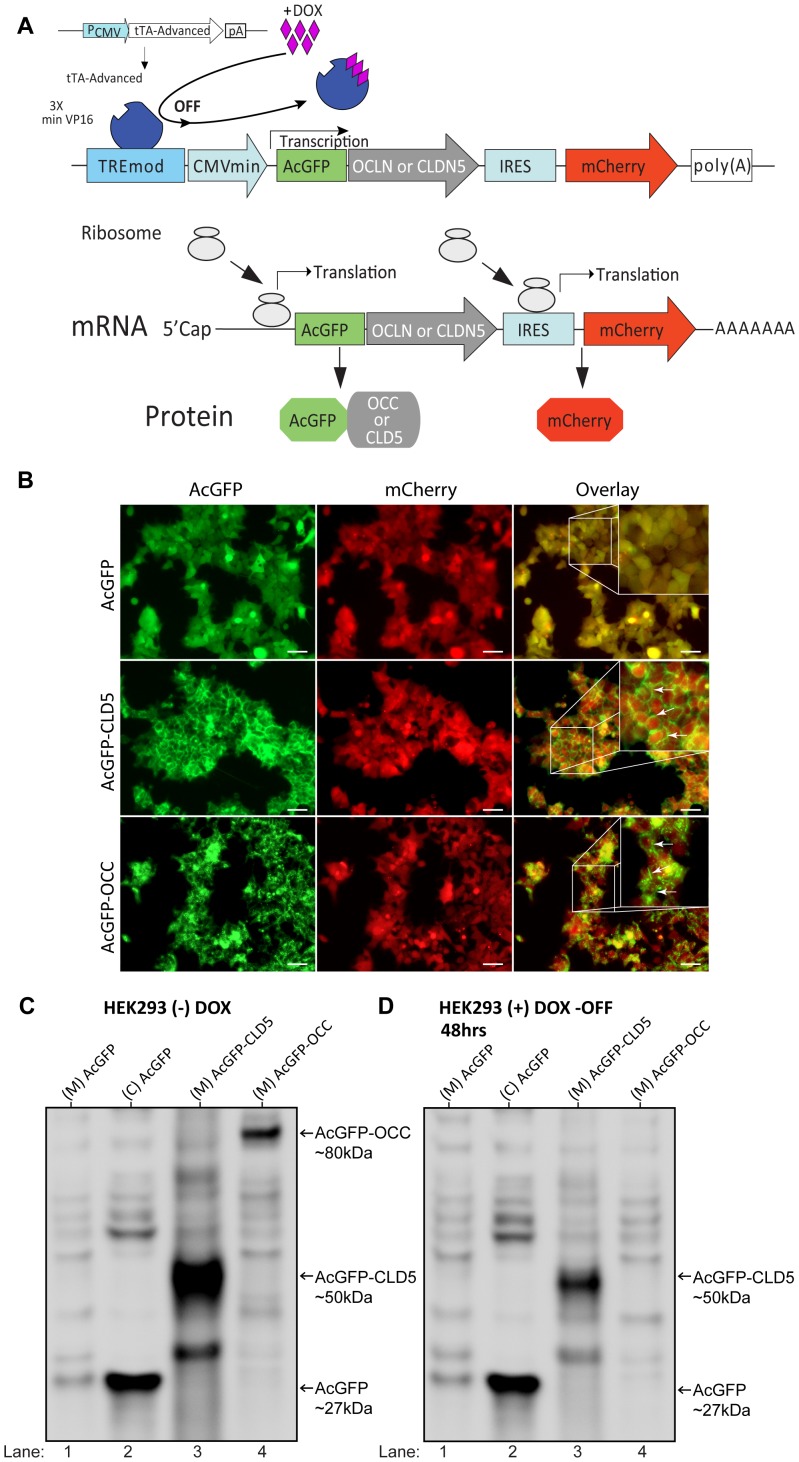
Cell-based assay for evaluating tight junction protein stability.(A) Schematic diagram of the “Tet-off” based TJ protein stability system. The system is designed to use reporter constructs which express bicistronic mRNA under the control of a tetracycline inducible promoter. The first cassette expresses the fusion protein of AcGFP with human claudin-5 or occludin at the N-terminus. The second cassette expresses mCherry red fluorescence protein after the internal ribosome entry site (IRES). In the induced state, the Tet-transactivator protein (tTA) activates transcription by binding to the TRE element. In the un-induced state, the addition of doxycycline (Dox) prevents the tTA protein from binding to the TRE promoter region, thereby blocking transcription. Once turned off, the level of protein turnover can be determined from the ratio of the GFP fused protein to mCherry as a function of time. (B) Representative images from HEK293 cells transfected with the tight junction protein stability system constructs. The top left panel shows the cytosolic expression of unfused AcGFP. The middle and lower left panels show the membranous expression of AcGFP-CLD5 and AcGFP-OCC, respectively. The cytosolic expression of mCherry is shown for all constructs (middle column). Original objective magnification was 20X and 60X (insert), scale bars:50 microns. (C) Western blots probed for GFP showing the expression of the fused tight junction proteins without (left) and with doxycycline (Dox, 200 ng/ml) for 48 hr. The expression of unfused AcGFP is observed in the cytosolic fraction (lane 2) and not in the membrane fraction (lane 1). The levels of membrane-bound AcGFP-CLD5 and AcGFP-OCC shown in the membrane fraction are depleted when in the presence of doxycycline. (M) indicates membrane fraction; (C) indicates cytosolic fraction.